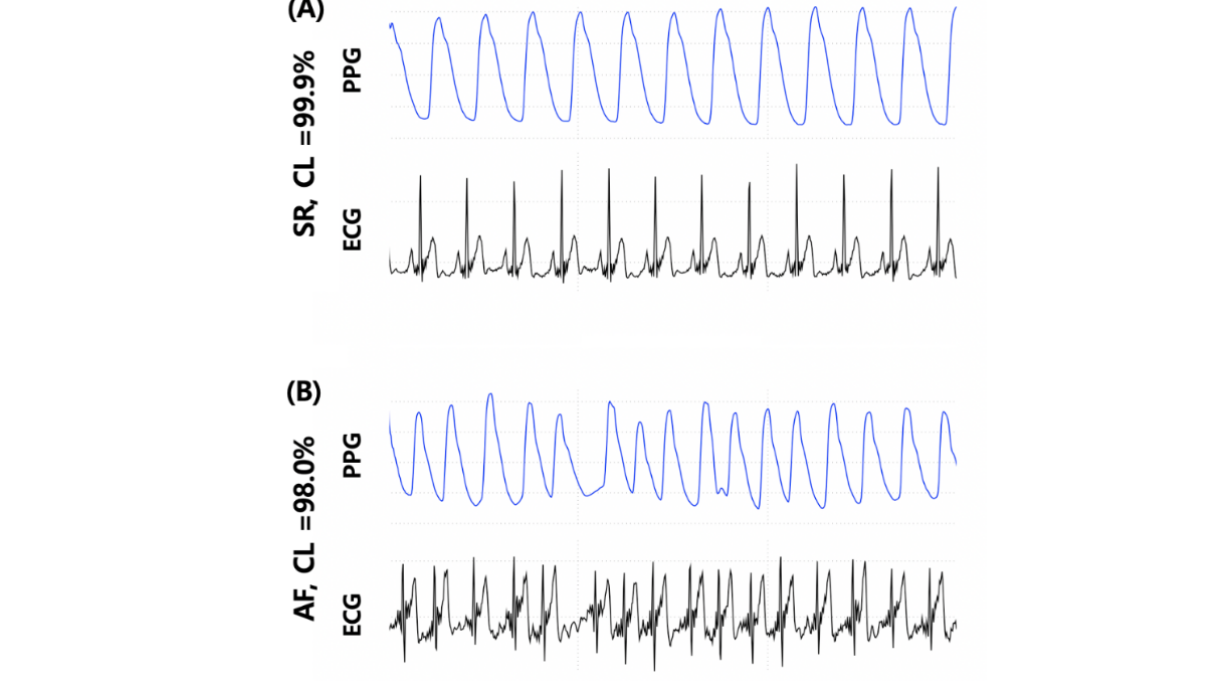
Figure 2. Typical examples of 15-second-long photoplethysmography and corresponding synchronized electrocardiogram samples for (A) stereotypic normal sinus rhythm and (B) atrial fibrillation with suggested confidence level using the 1-dimensional convolutional neural network algorithm. AF: